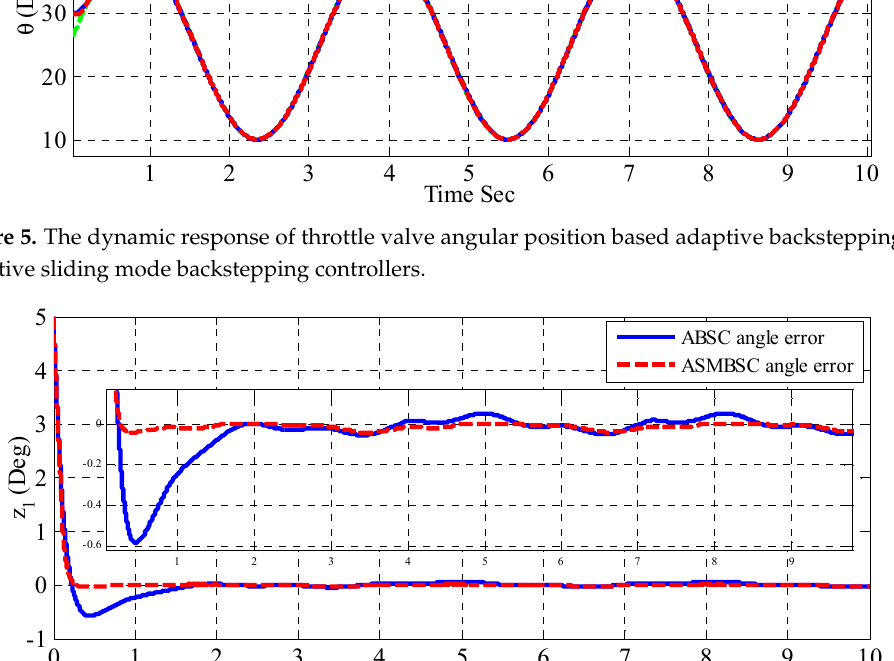
Figure 7. Plate angular speed response based on adaptive backstepping and adaptive sliding mode backstepping controllers. Figure 8 shows the behavior of control efforts given by both controllers, where the adaptive backstepping controller requires less control effort at transient than that needed by the adaptive sliding mode one. However, it is interesting to measure the root mean square of control effort over the entire simulation time. It has shown that the RMS of voltage signal required by adaptive sliding mode controller is less than required by adaptive backstepping controller as reported in Table 2. The main problem that has been observed with an adaptive sliding mode controller is the chattering behavior seen in its control effort envelope. However, Table 2 reports the performance numerical evaluation of both controllers.